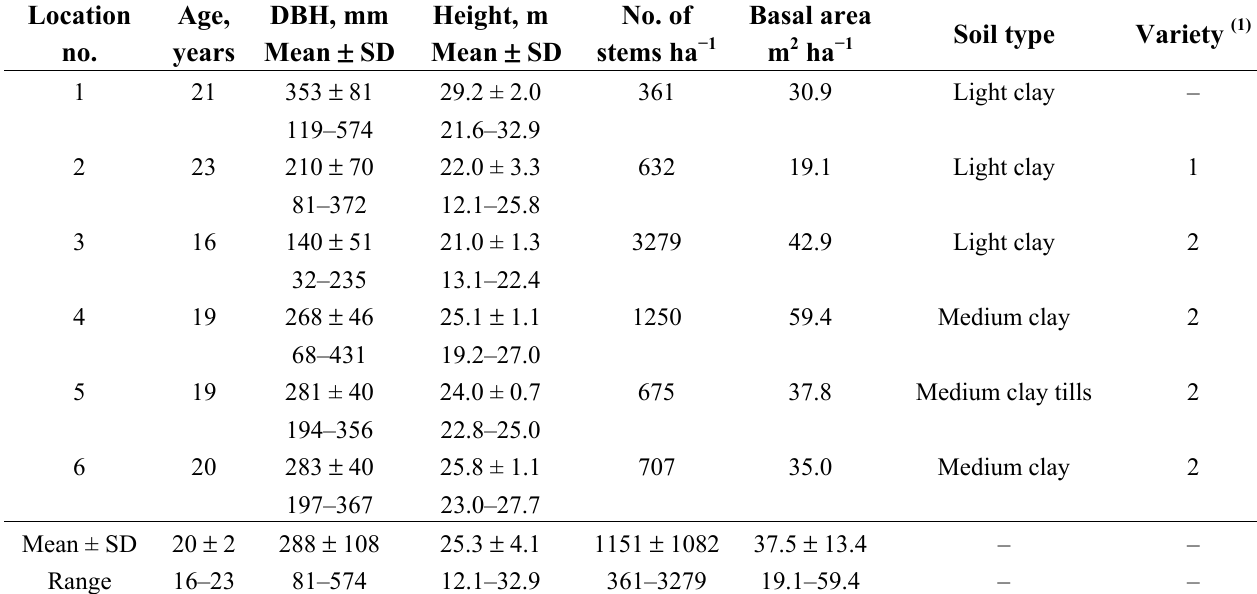
Table 1. Main characteristics of hybrid poplar stands growing at six locations in Sweden.